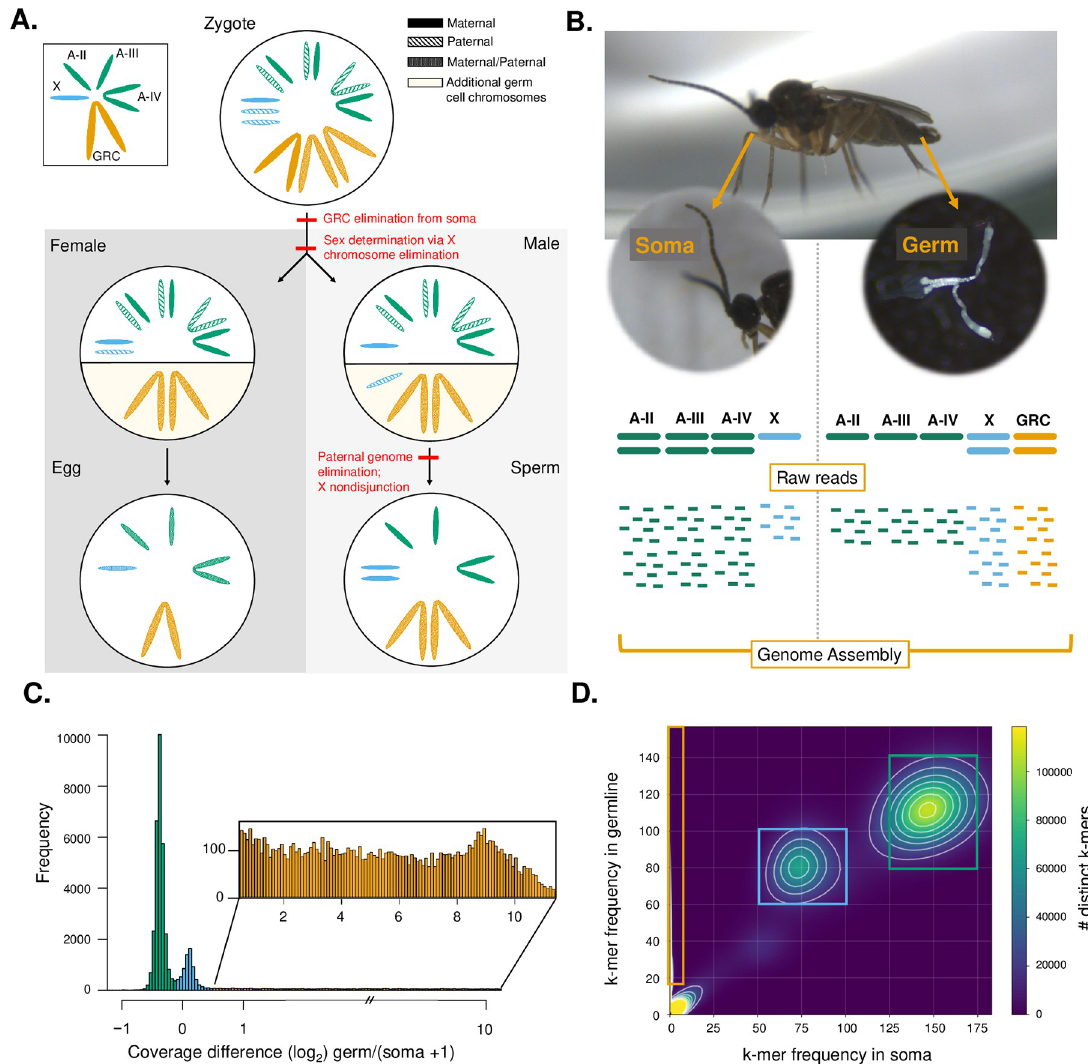
Fig 1. GRC transmission and sequencing and identification of GRCs through comparison of germline and soma coverage. (A) B . coprophila has 3 autosomes (A, green), an XO sex determination system (X chromosome shown in blue), and GRC (orange). Paternal origin chromosomes = dashed, maternal origin chromosomes = solid, either maternal or paternal origin chromosomes = dotted. Chromosomes below the solid line in males and females are additional chromosomes present in germline cells but eliminated from somatic cells. B . coprophila GRCs are eliminated from somatic cells in early embryogenesis. Some X chromosomes (always paternally inherited) are also eliminated from somatic cells early in development to determine sex. Males undergo paternal genome elimination such that (apart from the GRCs) only maternally inherited chromosomes are transmitted through the sperm (including 2 copies of the maternally derived X chromosome due to a nondisjunction event in meiosis). Chromosome sizes and shapes approximated from [21]. (B) Schematic of sequencing approach for identifying GRC sequences in B . coprophila . We isolated and sequenced somatic (head) and germline (testes with sperm) tissue, which differ in the number of autosomes (A-II, A-III, and A-IV), X chromosomes, and GRCs. We used the differences in chromosome constitution to isolate regions belonging to each chromosome type in a genome assembly made from short-read sequences from both tissue types. (C) Histogram of per scaffold log 2 coverage differences between germline and somatic tissues. Green regions were assigned as autosomal, blue assigned as the X chromosome, and orange assigned as the GRCs (inset). Note that 1 was added to the number of somatic reads to ensure noninfinite log 2 coverage differences for GRC scaffolds. (D) Comparison of k-mer (27-mer) frequency differences between reads in the germline and soma libraries. K-mers were mapped to the genome assembly and scaffolds assigned based on which type of k-mers (GRC, X chromosome, or autosomal) mapped to the scaffold and what proportion of the scaffold had k-mers mapping to it ( S2 Fig ). Boxes show coverage of k-mers assigned as autosomal (green), X chromosome (blue), and GRC (orange). Location of data used to generate Fig 1C and 1D is specified in S1 Table . GRC, germline-restricted chromosome.